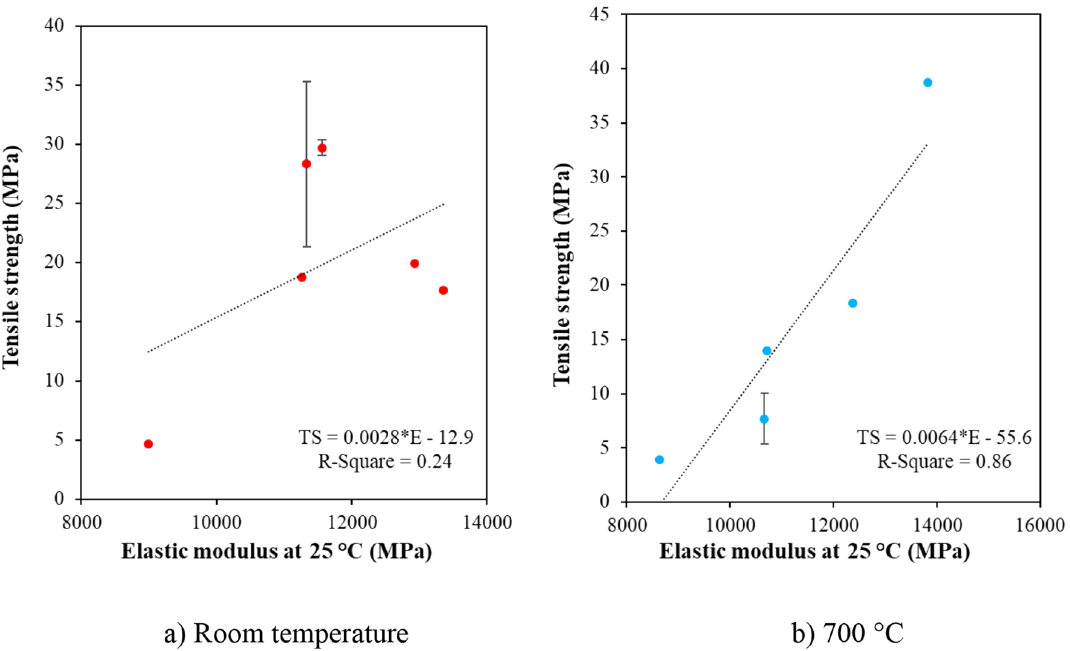
sible and the relevant formulae are provided. Parameters TS and E stand for tensile strength and elastic modulus at 25 °C, respectively